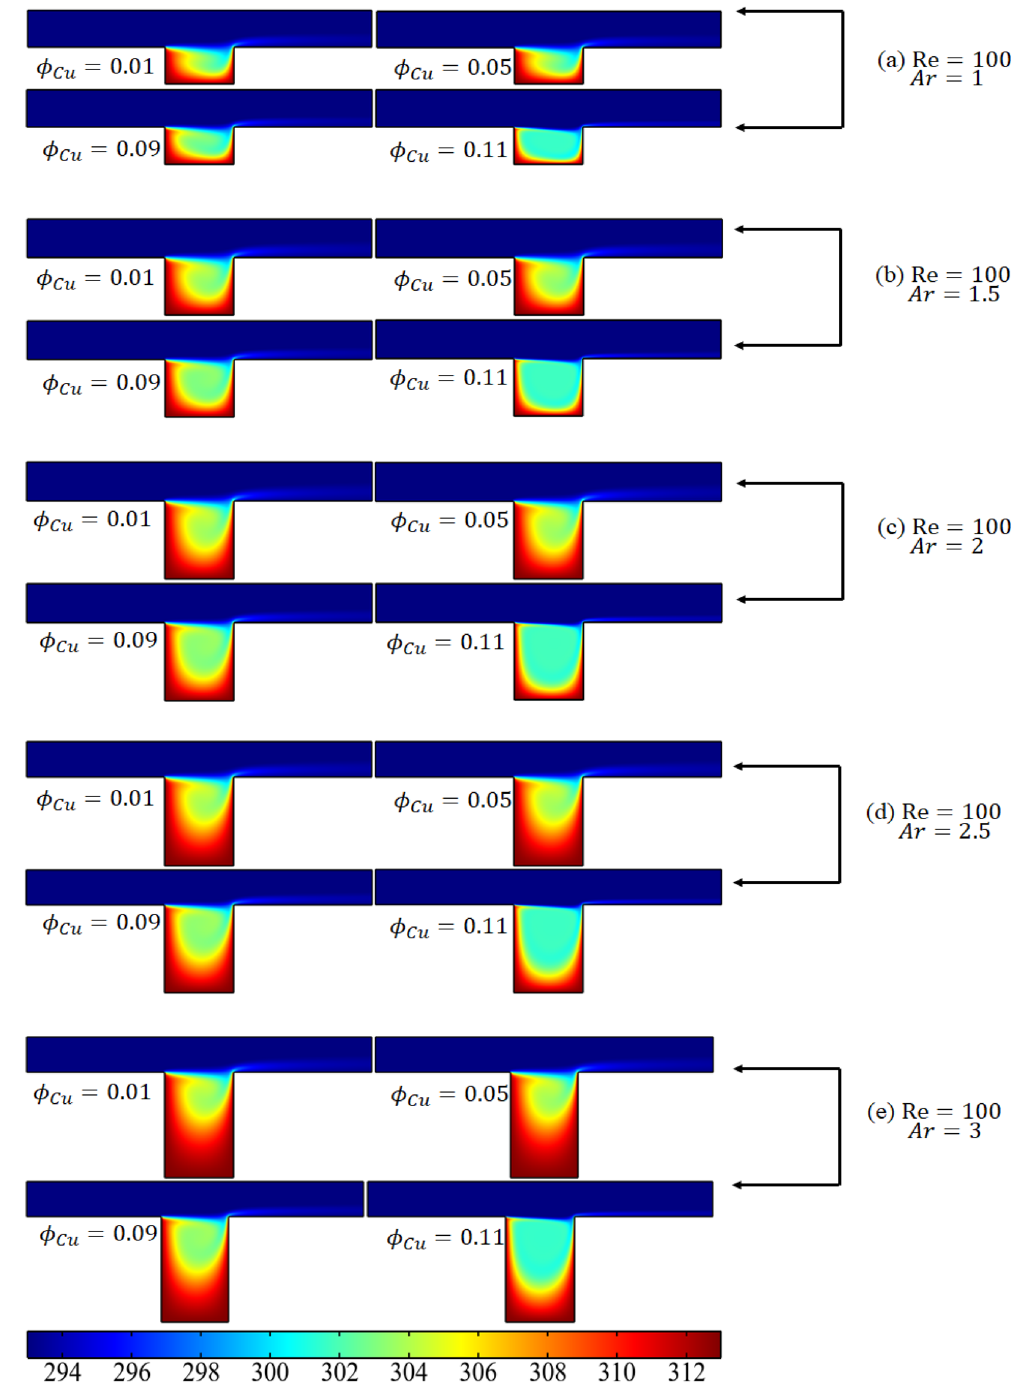
Figure 6. The temperature distribution in the cavity when Re =